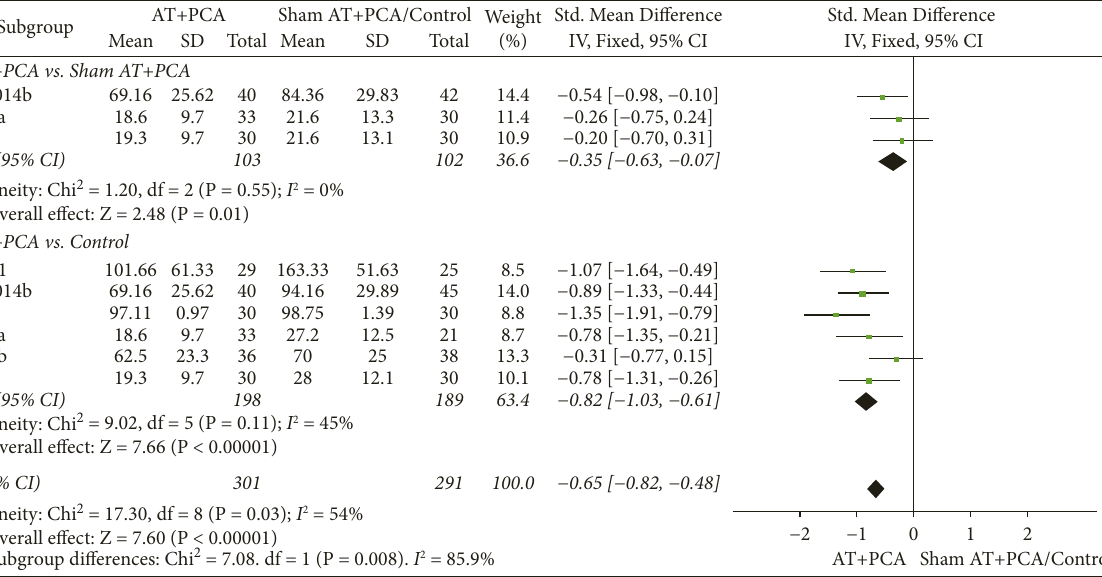
Figure 4: Forest plots of postoperative opioids consumption. AT: acupuncture. Incidence of postoperative PCA-related total complications